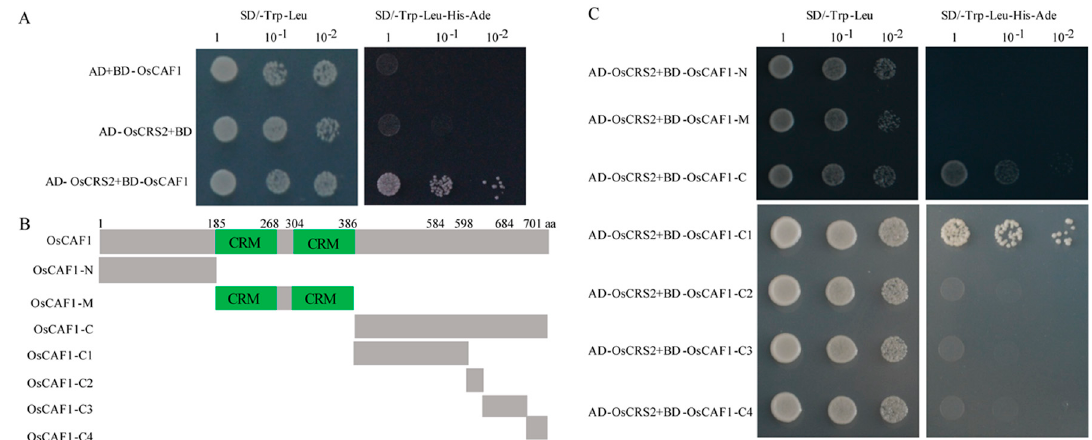
Figure 7. C-terminal of OsCAF1 interacts with OsCRS2. ( A ) OsCAF1 interacts with OsCRS2. The full-length CDS sequences of OsCAF1 and OsCRS2 were cloned into PGBKT7 (BD) and PGADT7 (AD) vector, respectively, to generate BD-OsCAF1 and AD-OsCRS2 constructs. The successfully cloned two constructs were then co-transformed into yeast AH109 cells. AD + BD-OsCAF1 and BD + AD-OsCRS2 constructs were used as control. ( B ) The protein structure of OsCAF1. Diagram of OsCAF1 protein structure and di ff erent structural domains of OsCAF1, OsCAF1-N (1-184), OsCAF1-M (185-386), OsCAF1-C (387-701), OsCAF1-C1 (387-584), OsCAF1-C2 (585-598), OsCAF1-C3 (599-684), and OsCAF1-C4 (685-701). ( C ) Yeast two-hybrid results of the interaction of OsCRS2 and OsCAF1. Truncated versions of OsCAF1 were cloning into BD vector and to generate BD-OsCAF1-N, BD-OsCAF1-M, BD-OsCAF1-C, BD-OsCAF1-C1, BD-OsCAF1-C2, BD-OsCAF1-C3 and BD-OsCAF1-C4 vectors. These vectors were co-transferred to AH109 yeast cells with AD-OsCRS2, respectively. Yeast cells were selected on synthetic dextrose medium lacking Leu and Trp (SD / -Trp-Leu) and the medium lacking Leu, Trp, His, and Ade (SD / -Trp-Leu-His-Ade) with di ff erent dilution series (1, 10 − 1 , and 10 − 2 ).